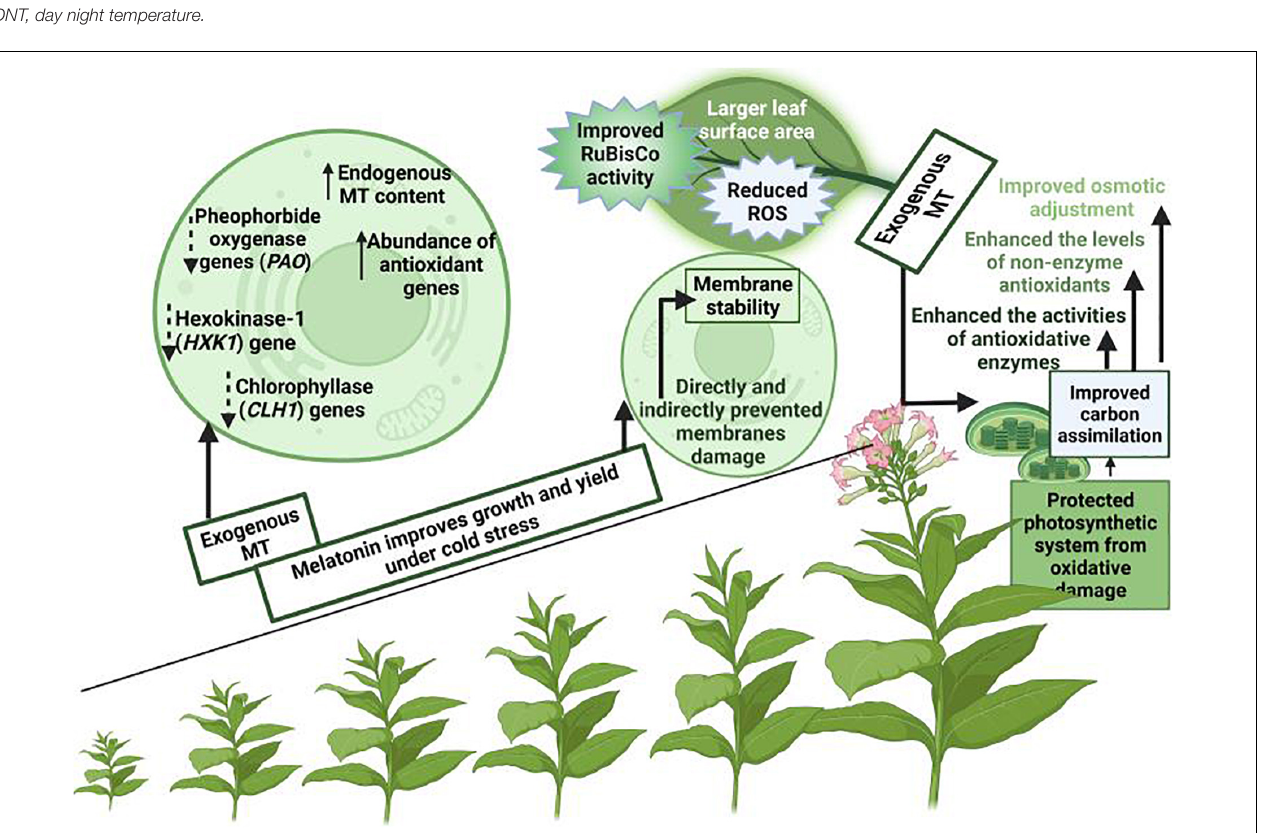
FIGURE 3 | A proposed model for MT induced increase in photosynthetic under cold stress. MT supplementation protects photosynthetic apparatus, and maintains genes expression linked with chlorophyll synthesis and improves the osmotic adjustment, carbon assimilation and anti-oxidant activities and resulting in significant improvement in photosynthesis under cold